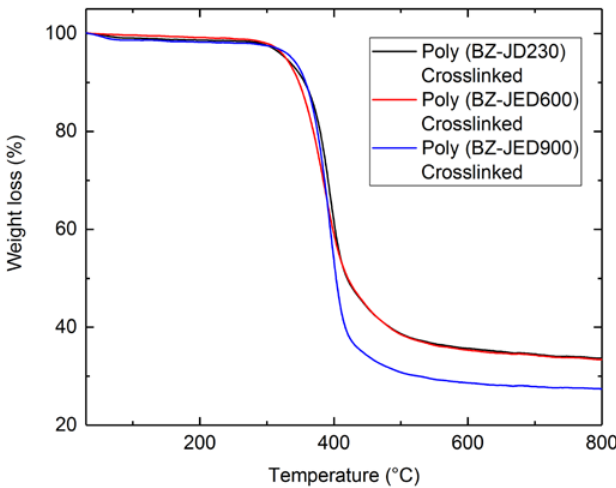
Figure 4. TGA of crosslinked PEG-based polybenzoxazine.